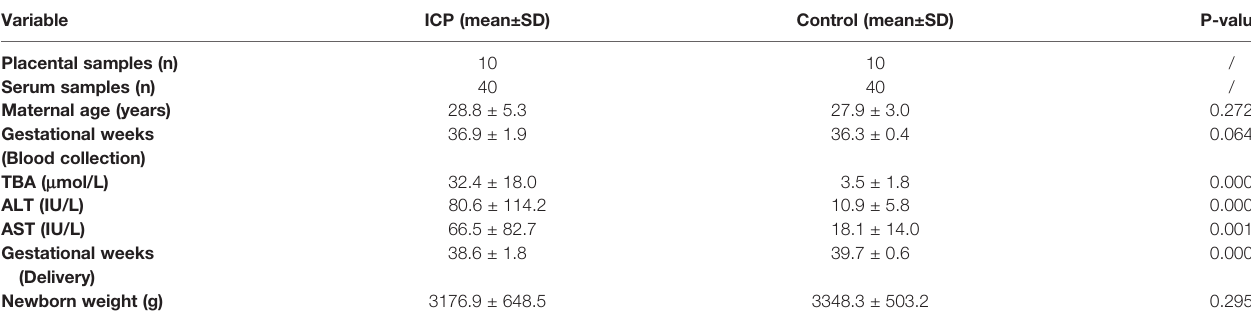
TABLE 1 | Clinical characteristics and perinatal outcomes of pregnant women with ICP and healthy pregnant controls.